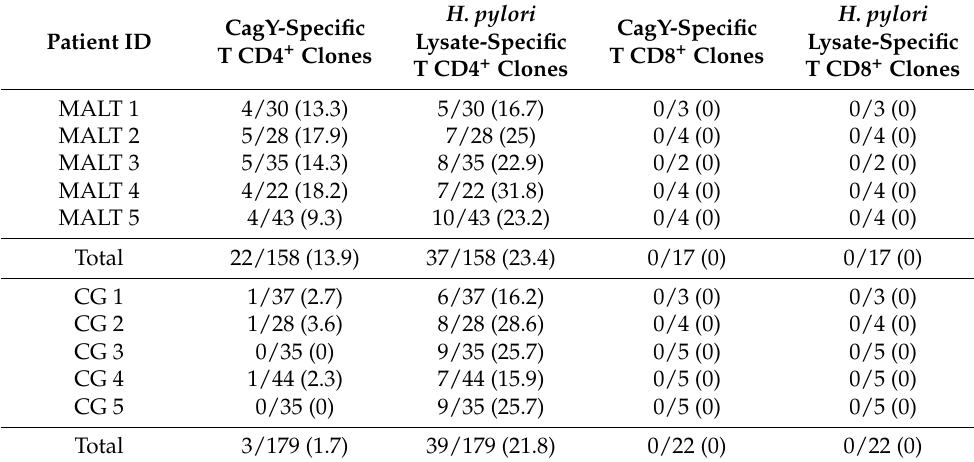
Table 1. Number (%) of CagY or H. pylori lysate-specific T cell clones isolated from biopsy specimens of MALT lymphoma (MALT) and chronic gastritis (CG) patients.